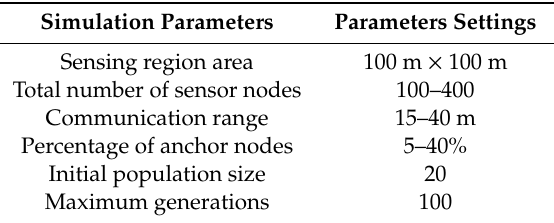
Table 5. Parameter settings for